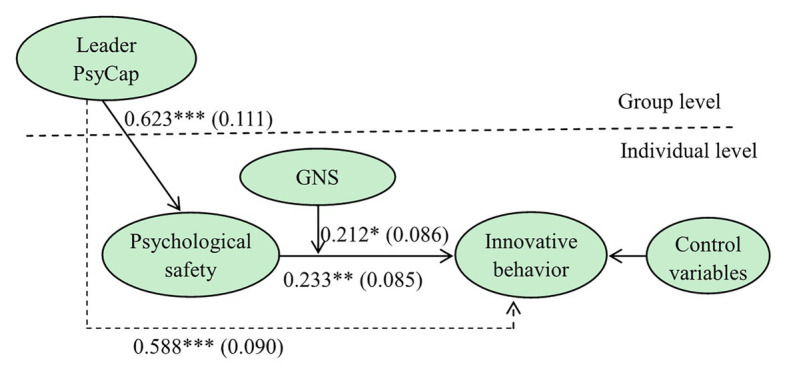
Analysis of the multilevel structural equation model.